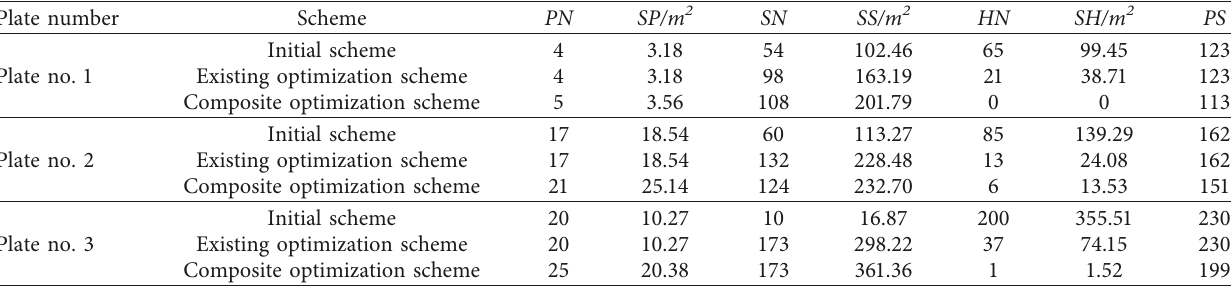
Table 6: Comparison of the number and area of panels in each scheme.